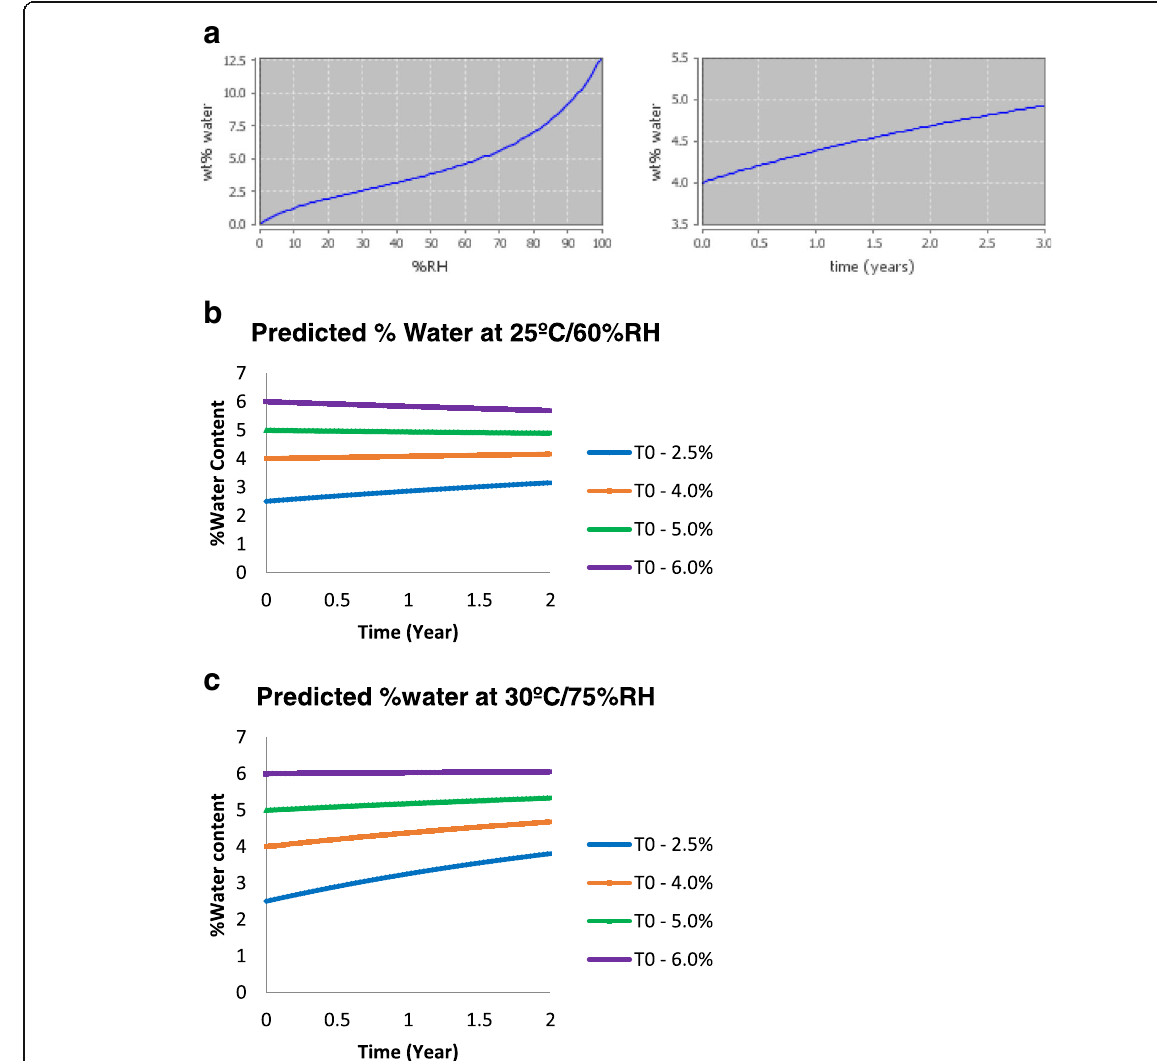
Fig. 4 a Predicted Water Isotherm ( left ) and the Predicted Water Content in the Tablets after Open-Dish Storage at 25 °C/60%RH (initial water content 4.0 %). b Predicted Water Contents in Tablets Packaged in Aclar Blisters Over 2 Years at 25 °C/60%RH with Different Initial Water